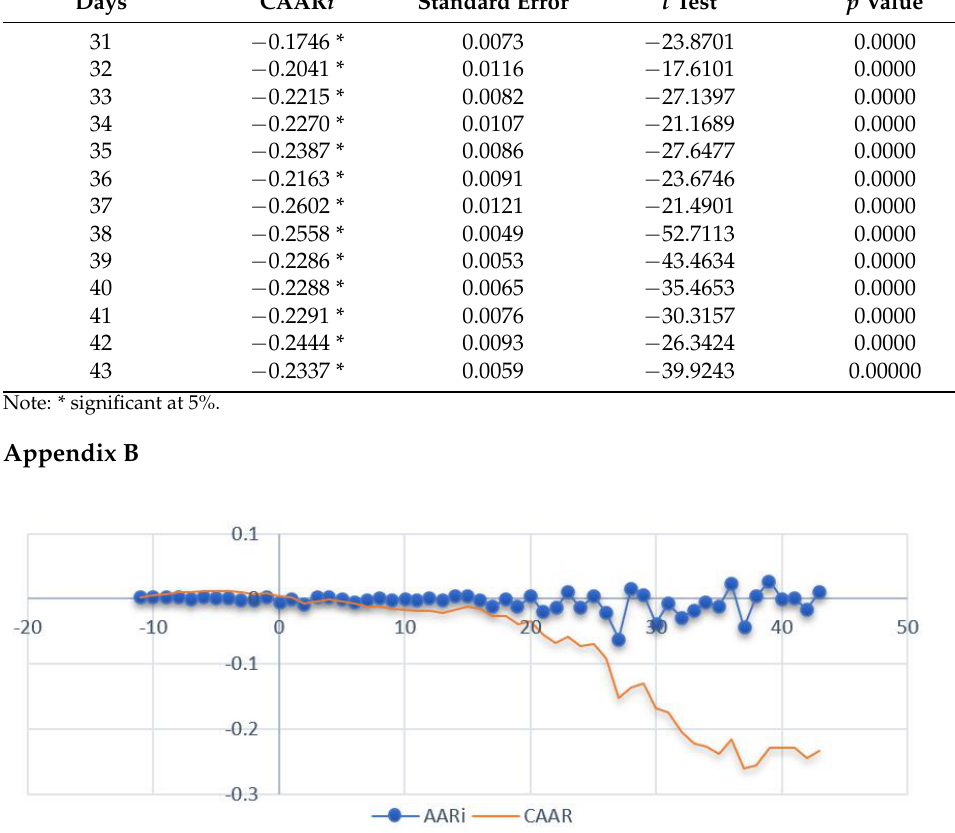
Figure A1. Cumulative abnormal return (CAR) of Thomson Reuters Islamic stock indices.